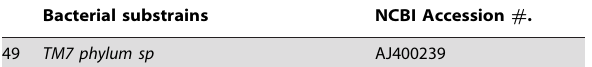
Bacterial substrains NCBI Accession # Figure S3 Confirmation of glucuronidated daidzein and daidzein in urine of WT and Oatp1a1-null mice. The authentic standard daidzein glucuronides were enzymatically synthesized from daidzein. The enzymatic reaction of daidzein resulted in three glucuronidated-daidzeins, suggesting that daid- zein can be glucuronidated at different positions. There is one peak with the same retention time as one of glucuronidated- daidzeins in the urine samples (a). In addition, there are four peaks with the same molecular weight as daidzein in the urine samples,